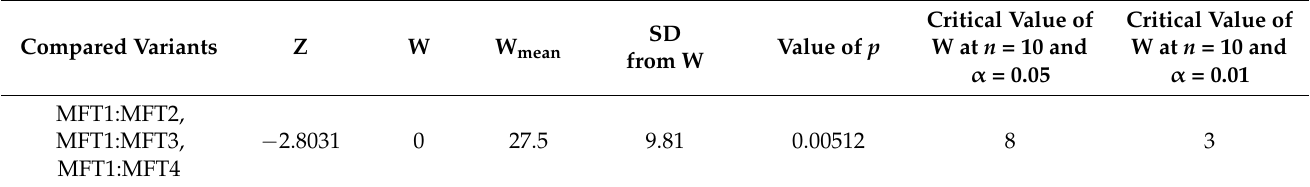
Table 4. Calculated statistical values of Z and W, standard deviation (SD) from W, value of p and critical value of W at the level of significance α = 0.05 and α = 0.01 (MFT1, MFT2, MFT3, MFT4— experimental variants).